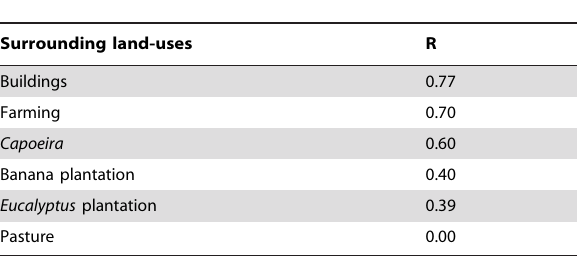
Table 2. Values of correlation coefficients between surrounding land-uses of forest fragments qualitatively measured in the field and the first PCA axis based on a product moment resemblance measure between